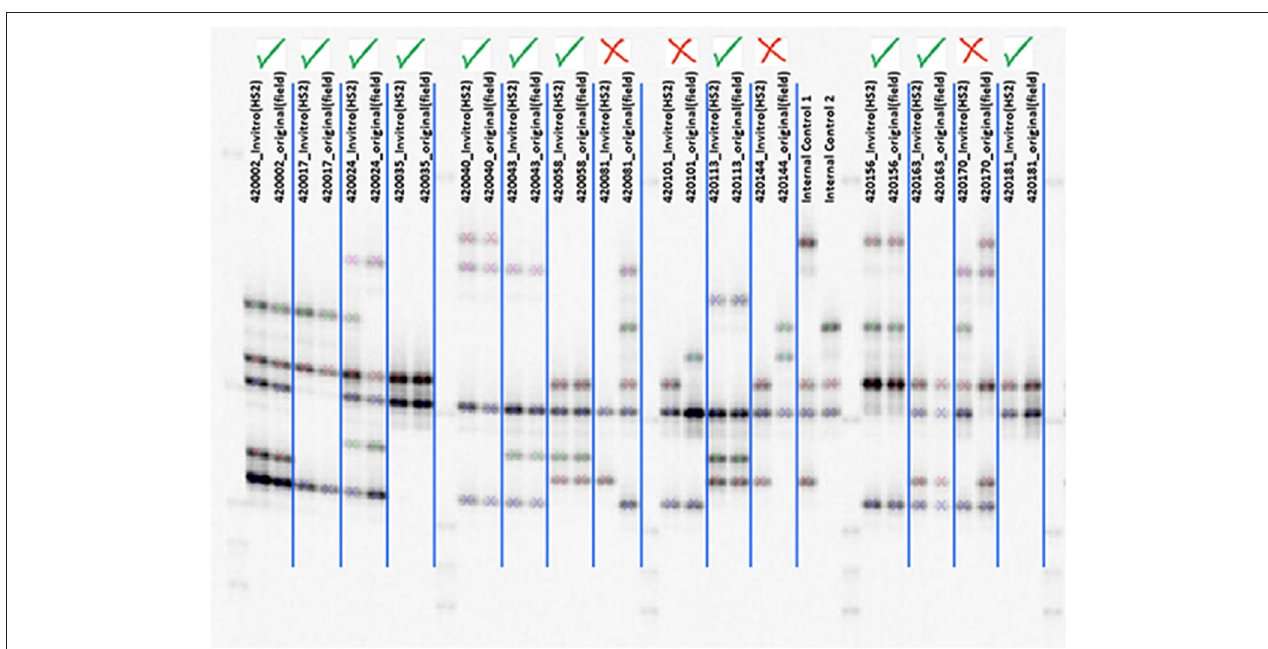
FIGURE 5 | Checking clonal identity using marker IBE2 shows allele patterns of in vitro and mother plants with a green check indicating a match and red X indicating a mismatch.